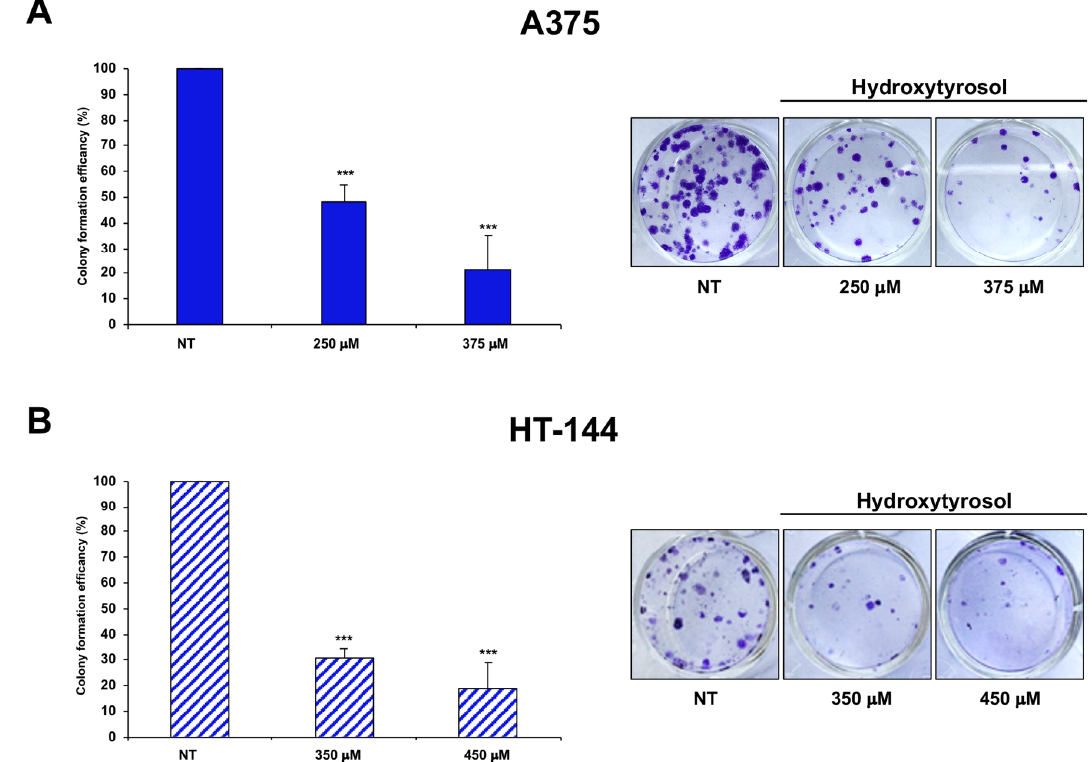
Figure 10. Cell colony assay of hydroxytyrosol treated melanoma cells. A375 cells ( A ) were treated with 250 µ M and 375 µ M of hydroxytyrosol and HT-144 cells ( B ) were treated with 350 µ M and 450 µ M of hydroxytyrosol for 24 h. The colony formation e ffi ciency of treated cells is the colony numbers formed by treated cells expressed as a percent of the colonies formed by untreated cells (NT) and is reported in the histograms ( A , B , left panels), as mean values of almost three di ff erent experiments. The error bars indicate the standard deviation and statistical significance was analysed by Student’s t -test: *** p < 0.001 very highly significant. In ( A , B ), right panels, bright-field photography of treated and untreated A375 ( A ) and HT-144 ( B ) cell colony are reported. The images are representative of almost three di ff erent